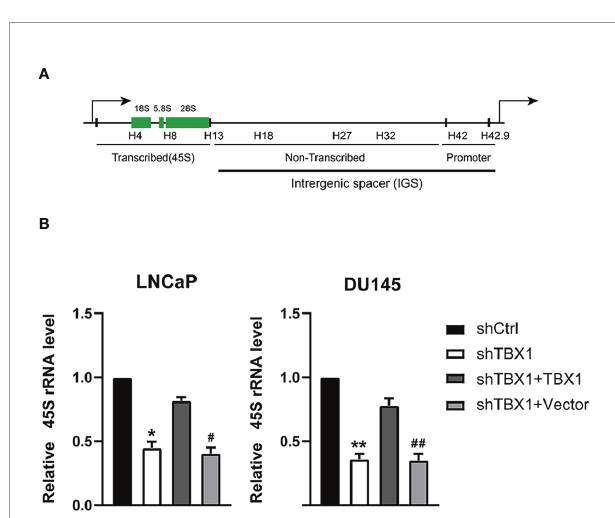
FIGURE 5 | TBX1 silencing suppresses the expression of45S rRNA, whichis rescued by the exogenous expressionof TBX1. (A) Schematic representationof one human rDNA repeat. (B) qPCR results of the effect of TBX1 on the expression of 45S rRNA inLNCaP and DU145 cells. The data represent the mean ± SD of three independent experiments. ** p < 0.01; * p < 0.05, shTBX1vs. shCtrl/shTBX1 +TBX1; ## p < 0.01; # p < 0.05, shTBX1+Vector vs.